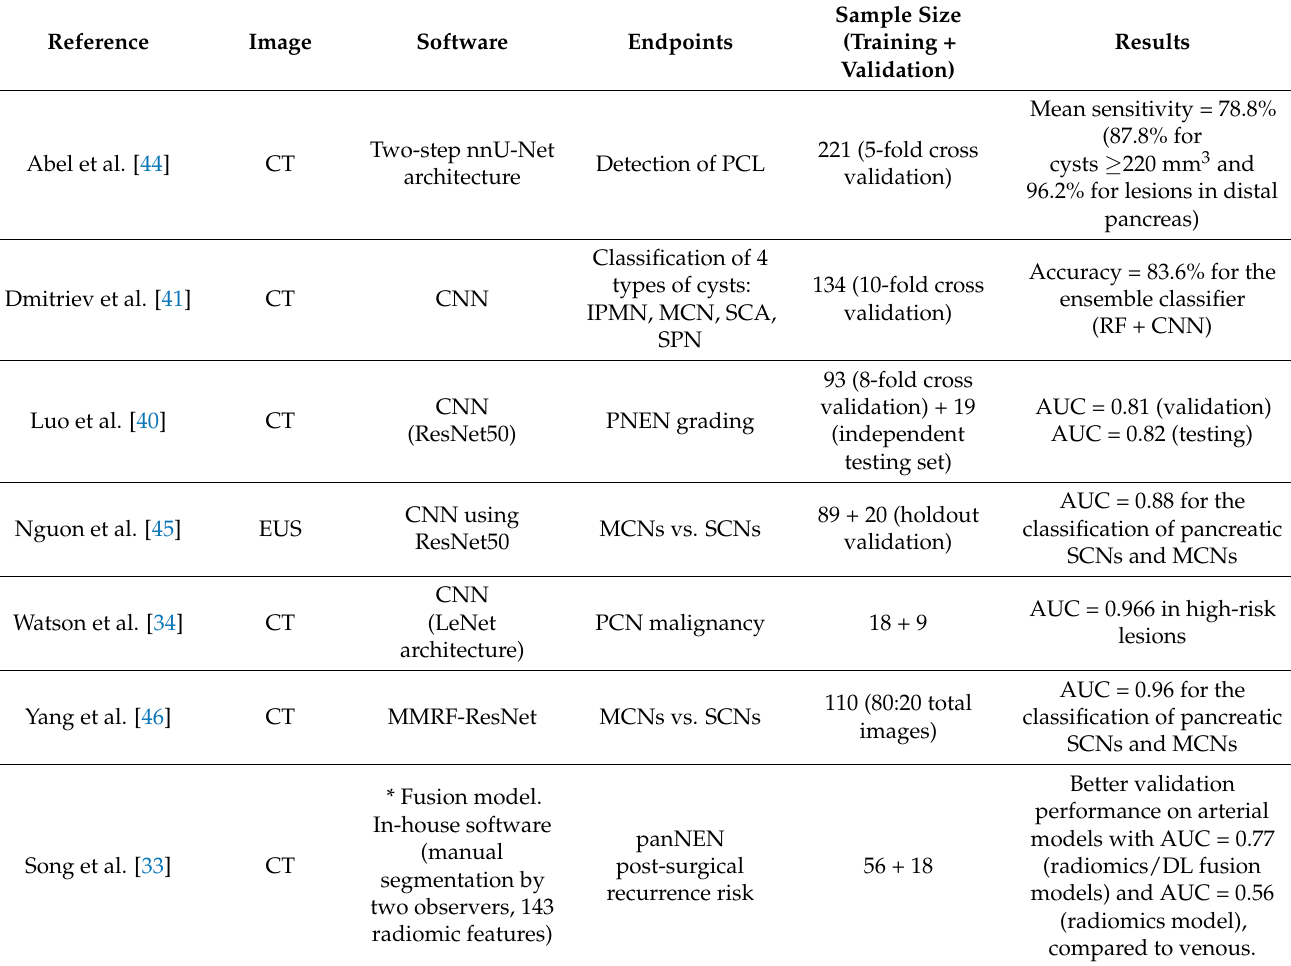
Table 2. Deep learning studies in diagnosing precancerous pancreatic